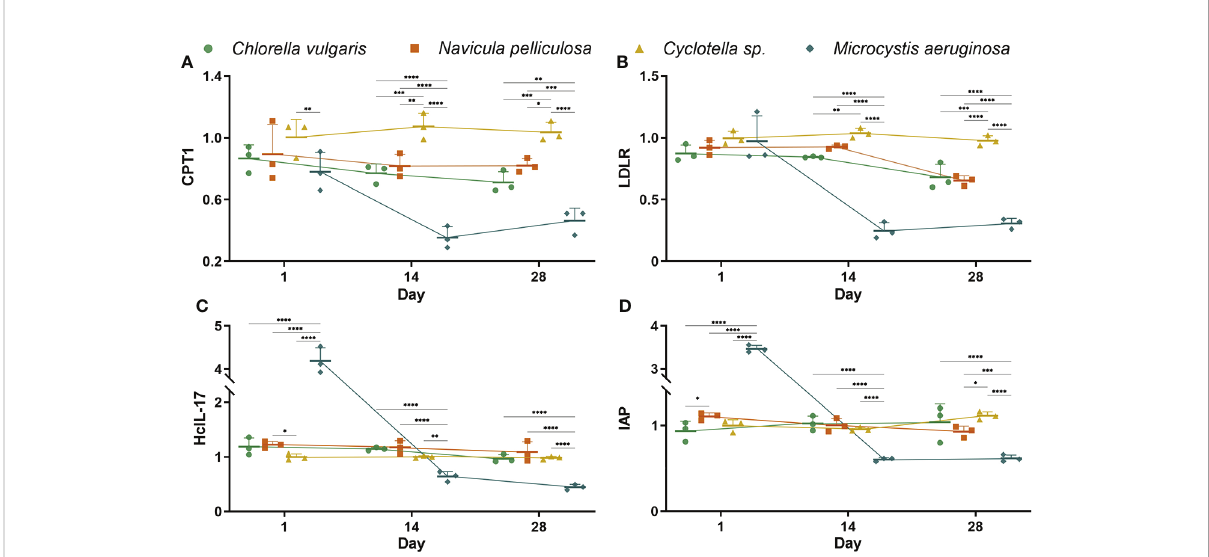
FIGURE 2 Relative expression levels of metabolic and immune-related genes in liver of Hyriopsis cumingii . Mussels exposed to four different microalgae treatments on days 1, 14, and 28. Metabolic genes: (A) CPT1 and (B) LDLR. Immune genes: (C) HcIL-17 and (D) IAP. The asterisk (*) indicates signi fi cant differences between four microalgae treatments at each sampling time (Tukey test, p < 0.05). Values are expressed as mean ± SD (n =